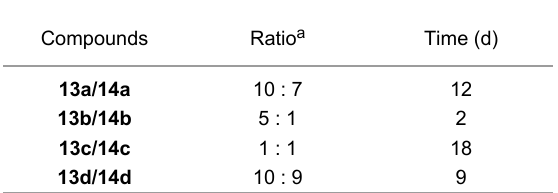
Table 1: Equilibrium between 13a–d and 14a–d in chloroform.